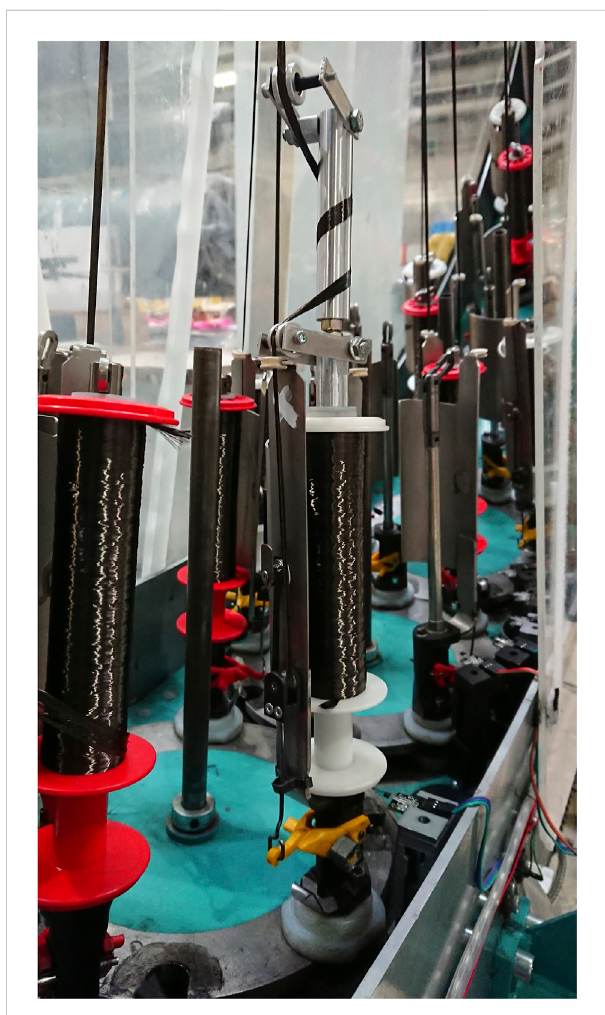
FIGURE 2 Barrel tensioner screwed onto a bobbin carrier in order to create a consistent level of elevated tension of a single yarn during the braiding experiments with a simulated